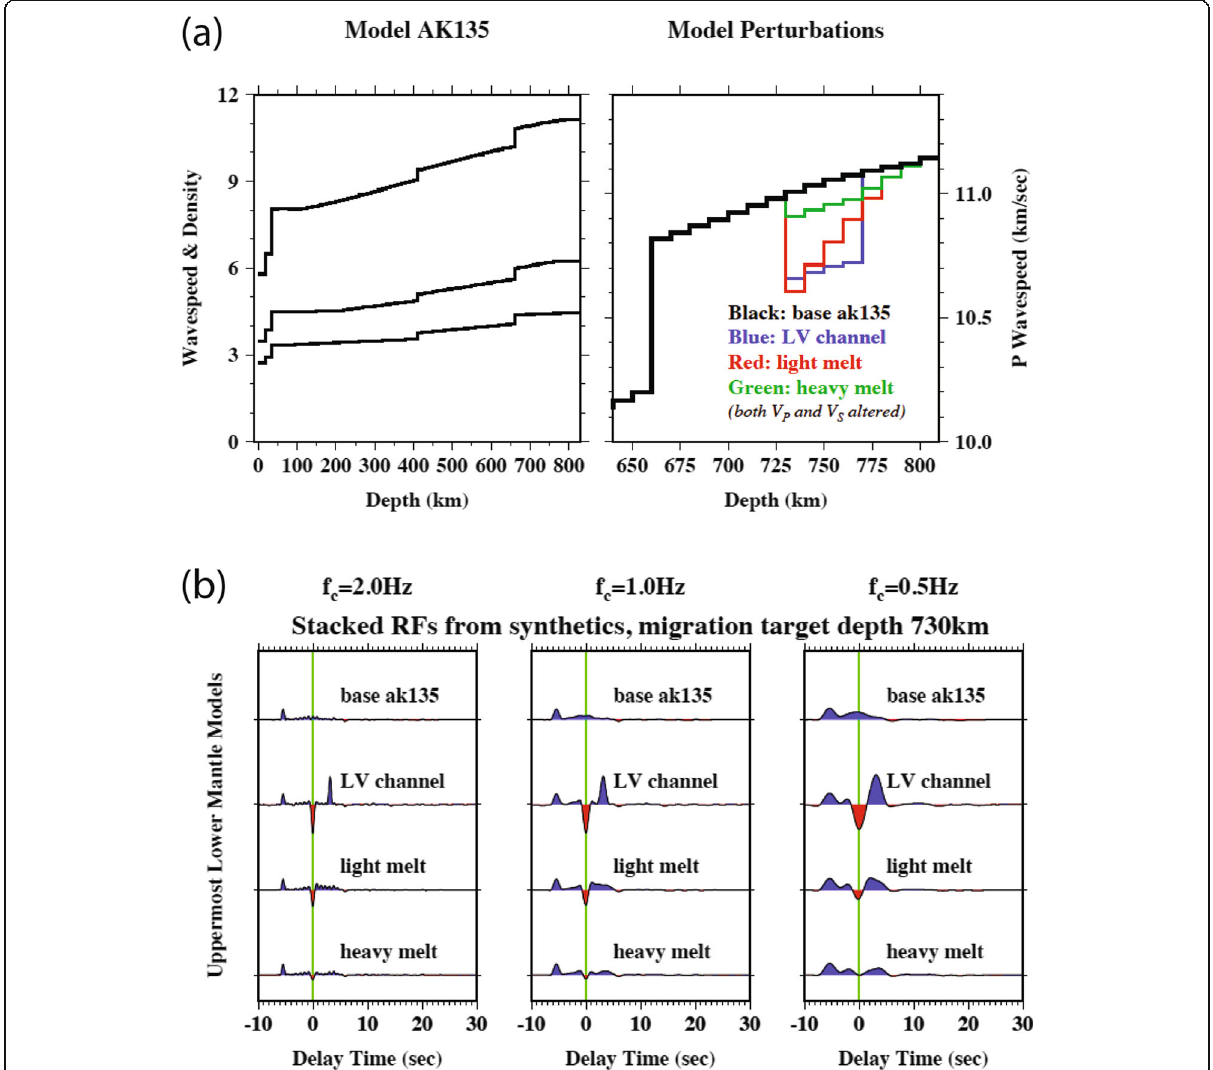
Fig. 14 Results of forward modeling of receiver functions for various models of LVL-750. a The velocity-depth relationship for various models of a LVL at ~ 750 km. b Corresponding receiver function. Three models are considered: (1) A low velocity channel cause by the presence of chemically distinct materials such as subducted oceanic crust (e.g., (Gréaux et al. 2019)). (2) A case for a heavy melt. In a region of down-welling background flow (i.e., subduction zones), heavy melt will drain down and there is no melt accumulation. Consequently, velocity is only slightly lower than the background velocity. (3) A case for a light melt. Light melt will be accumulated in s region of down-welling background flow (i.e., subduction zones) and a melt-rich layer will be formed resulting in a substantial velocity reduction near the top of the melt-rich